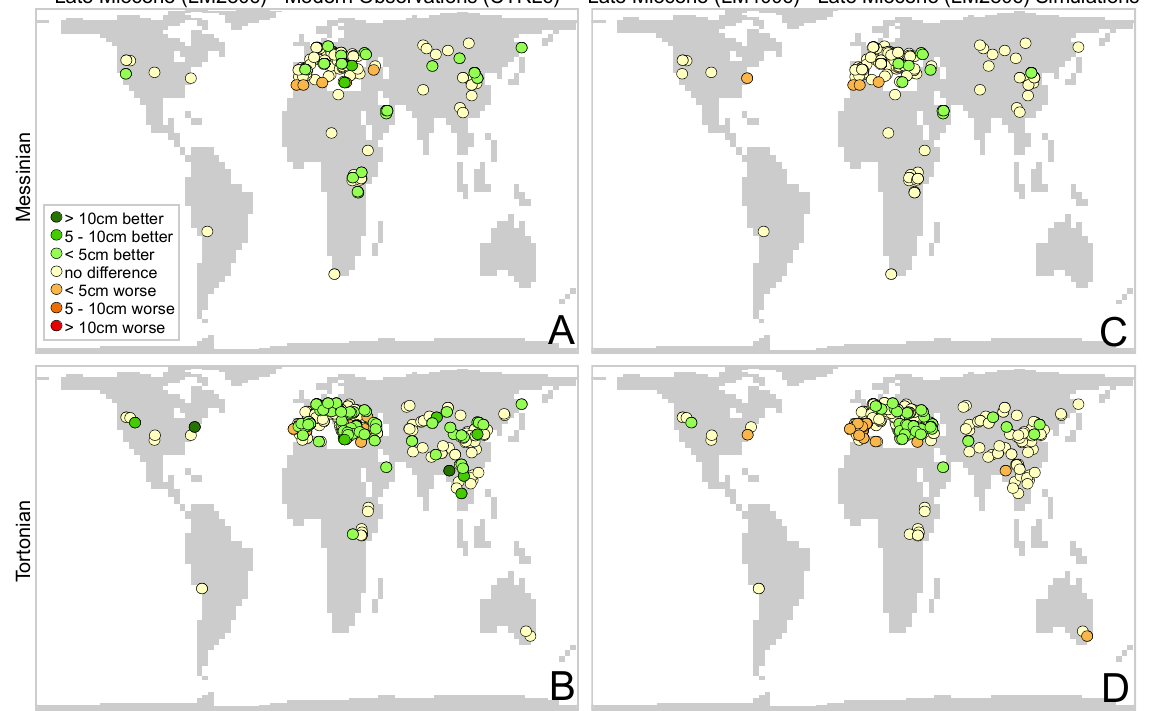
Fig. 14. Improvements in the model–data comparison for mean annual precipitation. The lefthand column (A, B) shows the improvement that the late Miocene palaeogeography makes to the model–data comparison. The righthand column (C, D) shows the improvement that higher CO 2 makes to the model–data comparison. Green circles indicate an improvement; red circles indicate a deterioration. The datapoints showing “no difference” are plotted underneath the other datapoints in order to highlight the